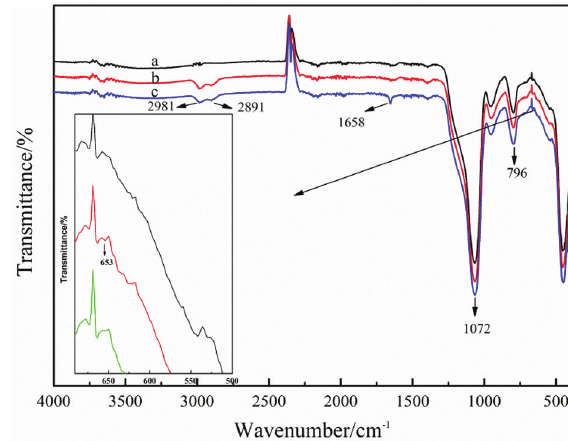
Figure 4: FT-IR spectra of (a) NS, (b) NS-Cl, (c) NS-DMAP.